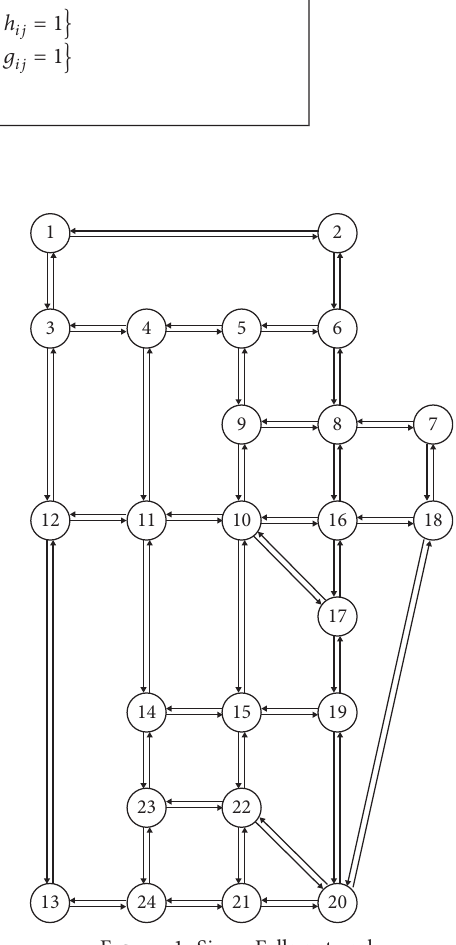
Figure 1: Sioux Falls